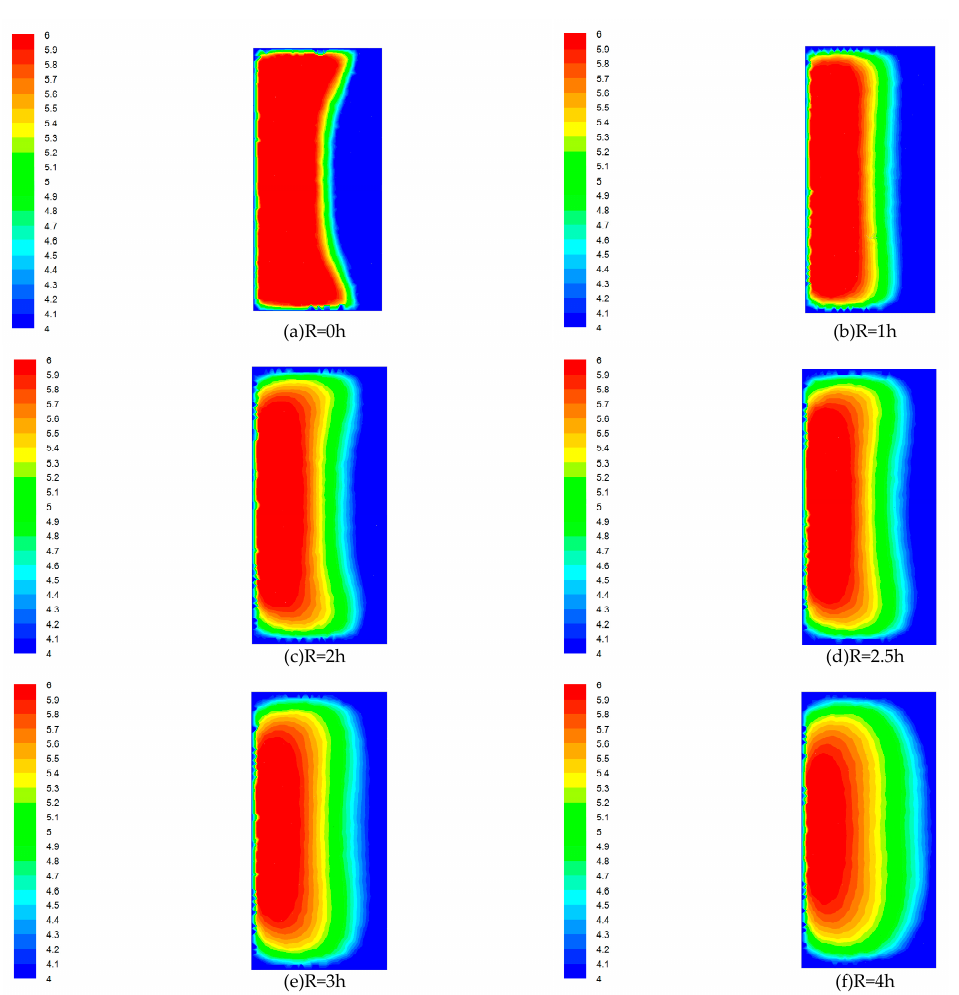
Figure 4. Velocity distribution cloud. (a) R = 0h; (b) R = 1h; (c) R = 2h; (d) R = 2.5h; (e) R = 3h; (f) R = 4h.